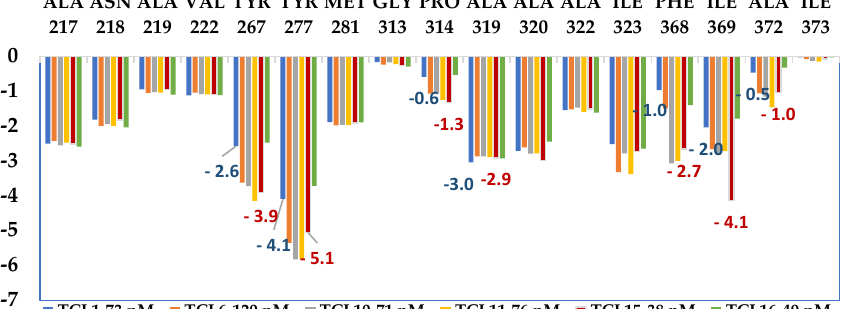
Figure 8. Plot of the energy of the intermolecular interaction E int between TCL inhibitors and Pf ENR, calculated by splitting the molecular mechanics into the contributions of individual residues for the most active TCL inhibitors, Table 1 [21,23,25,27], in [kcal · mol − 1